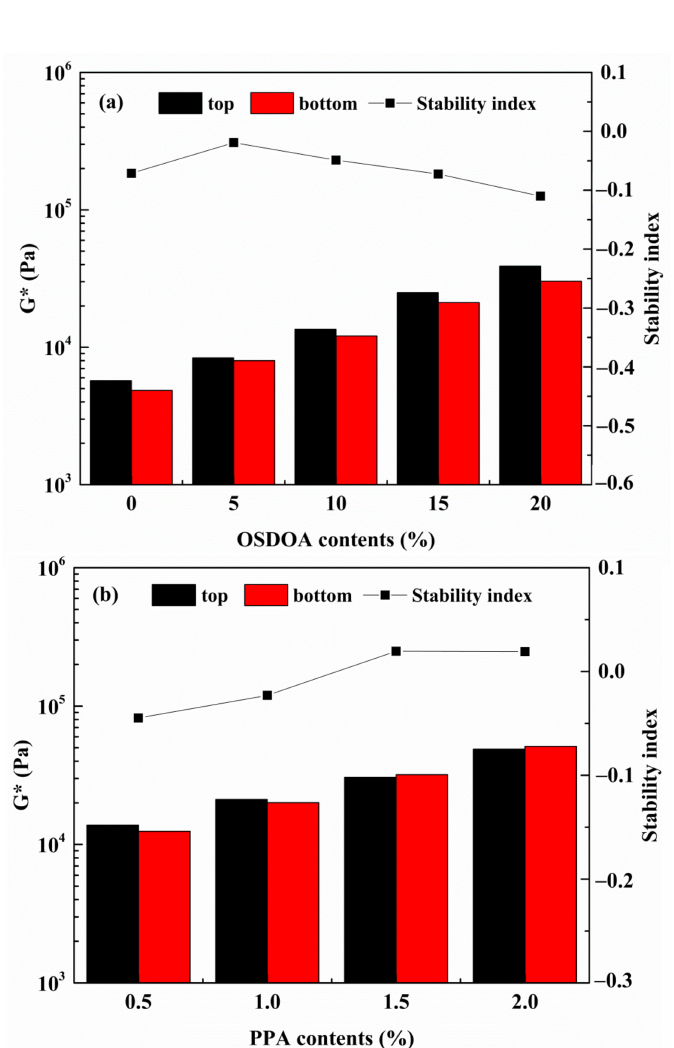
Figure 12. Variations in G* and the stability index with various OSDOA and PPA contents: ( a ) SBS/OSDOA-modified asphalts; ( b ) composite modified